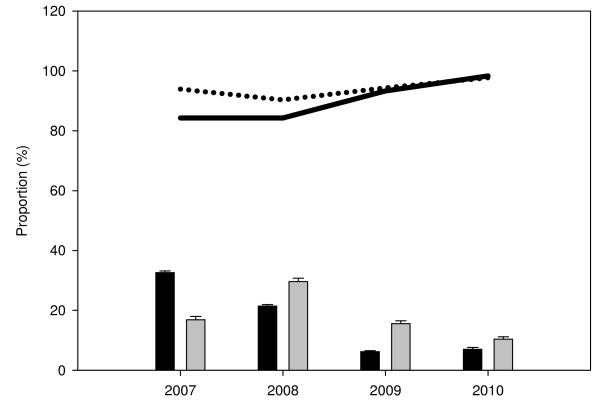
Specificity of RDTs by malaria parasite prevalence stratified by the year of study. Bars represent proportion of cases with positive blood smear results by microscopy by year of study from 2007 to 2010 (black bars = longitudinal study and grey bars = cross-sectional surveys - CSS); Solid line = specificity of RDTs in the longitudinal study and dotted line = specificity of RDTs in the cross-sectional surveys (CSS)